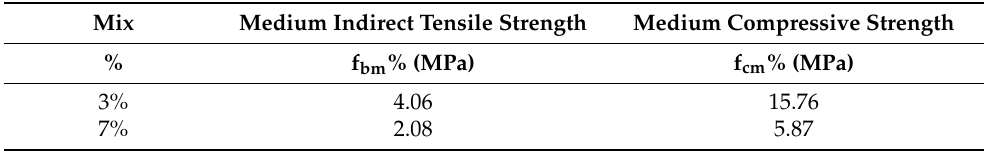
Figure 2. Mechanical tests on the prismatic specimen: ( a ) set ‐ up for the bending test; ( b ) break of the specimen after the bending test; ( c ) set ‐ up for the compression test on the half ‐ part of the prismatic specimen; ( d ) 40 mm imprint after the compression test. Table 2. Results of the mechanical tests for the two